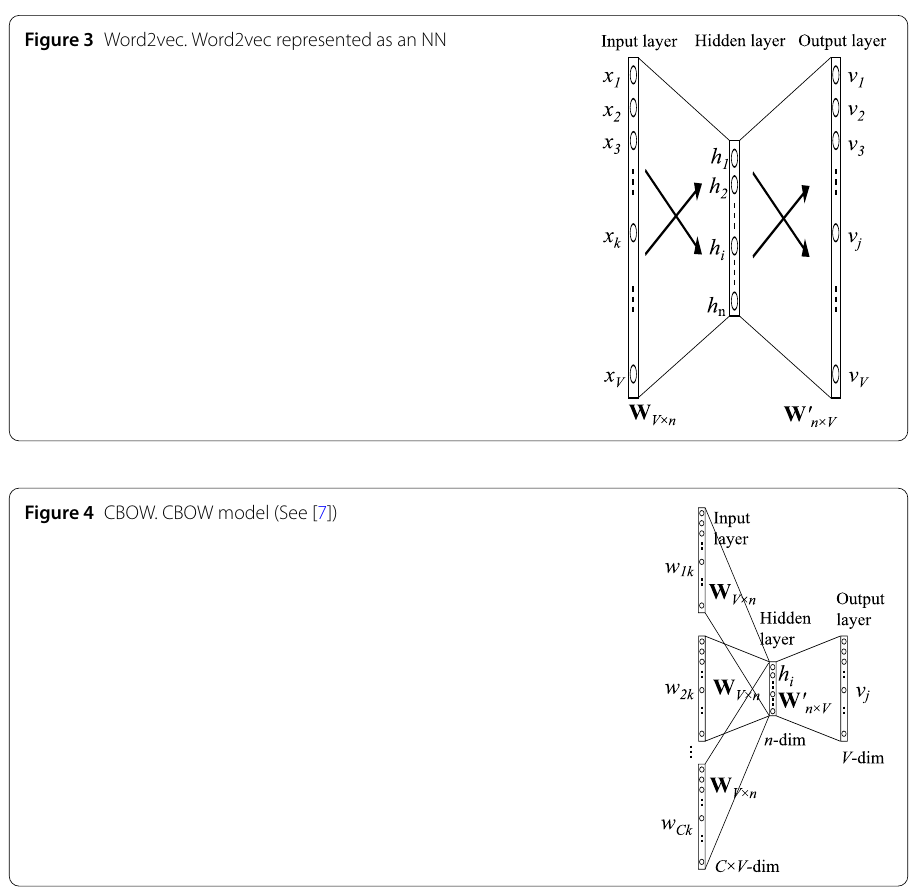
Figure 4 CBOW. CBOW model (See